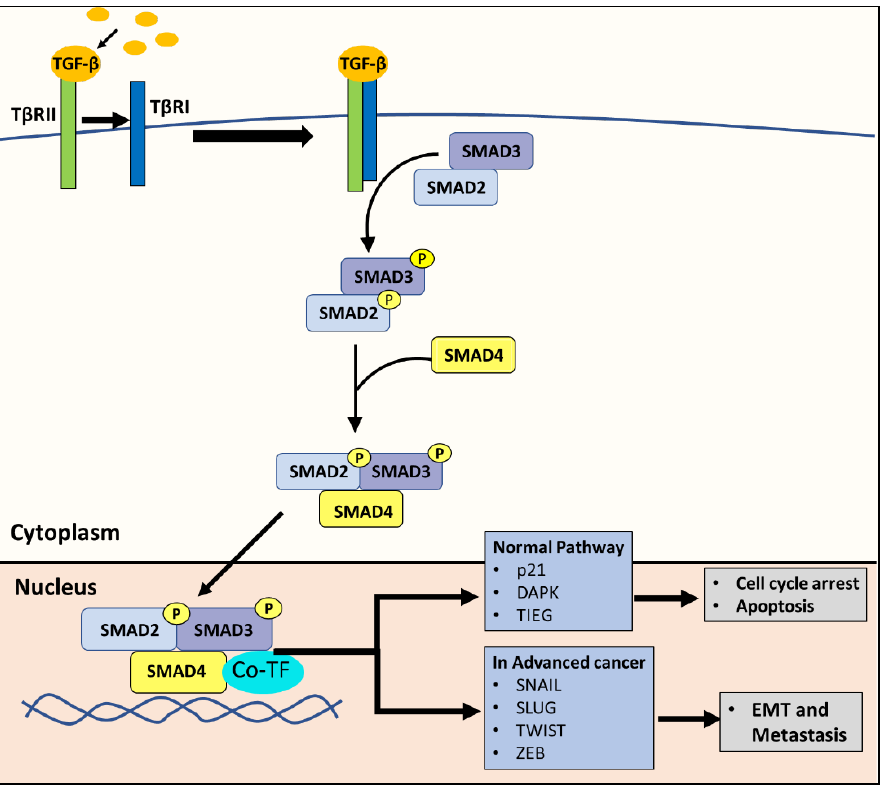
Figure 3. The canonical TGF- β pathway. The TGF- β ligand binds to the TGF- β type II receptor (T β RII). This binding induces TGF- β type I receptor (T β RI) to form a hetero-tetrameric complex with T β RII. T β RI subsequently phosphorylates SMAD2 and SMAD3, which then form a complex with SMAD4. Under physiological conditions in normal cells, the resulting SMAD2/3/4 complex translo- cates to the nucleus, recruits co-transcriptional factors, and activates genes involved in apoptosis and cell cycle arrest, such as the cyclin-dependent kinase inhibitor, p21, and the death-associated